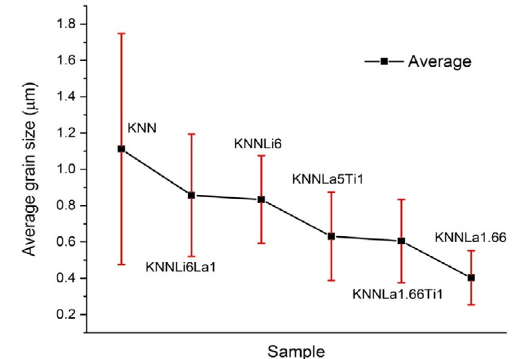
Fig. 6 Decrease in average grain size in ceramic samples by the action of dopants.